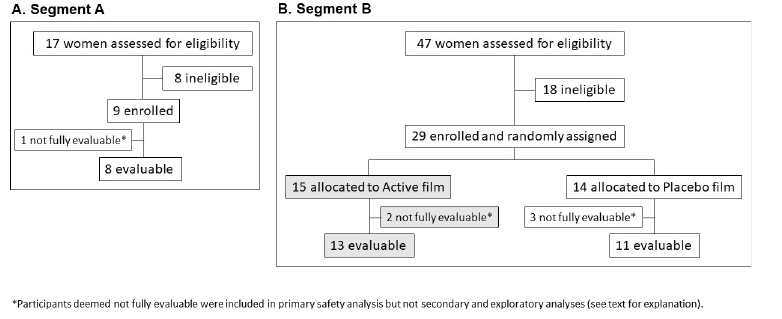
Fig 3. Diagram of MB66-01 enrollment.